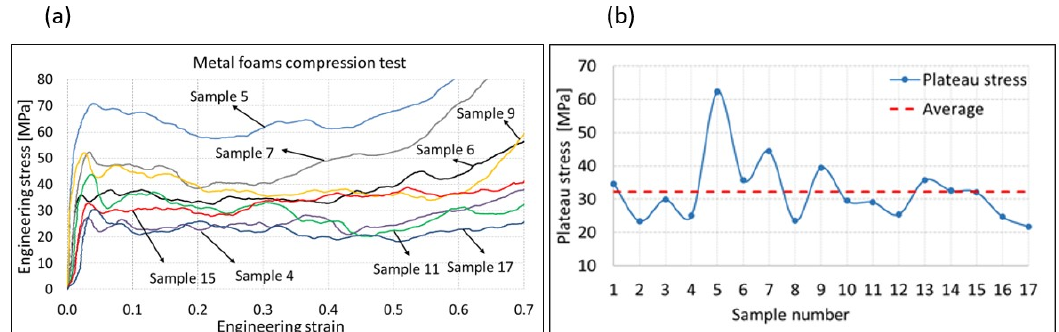
Figure 4. ( a ) Compression test diagram of eight samples randomly selected from the design of ex- periments. ( b ) Plateau stress values for all samples. experiments. ( b ) Plateau stress values for all